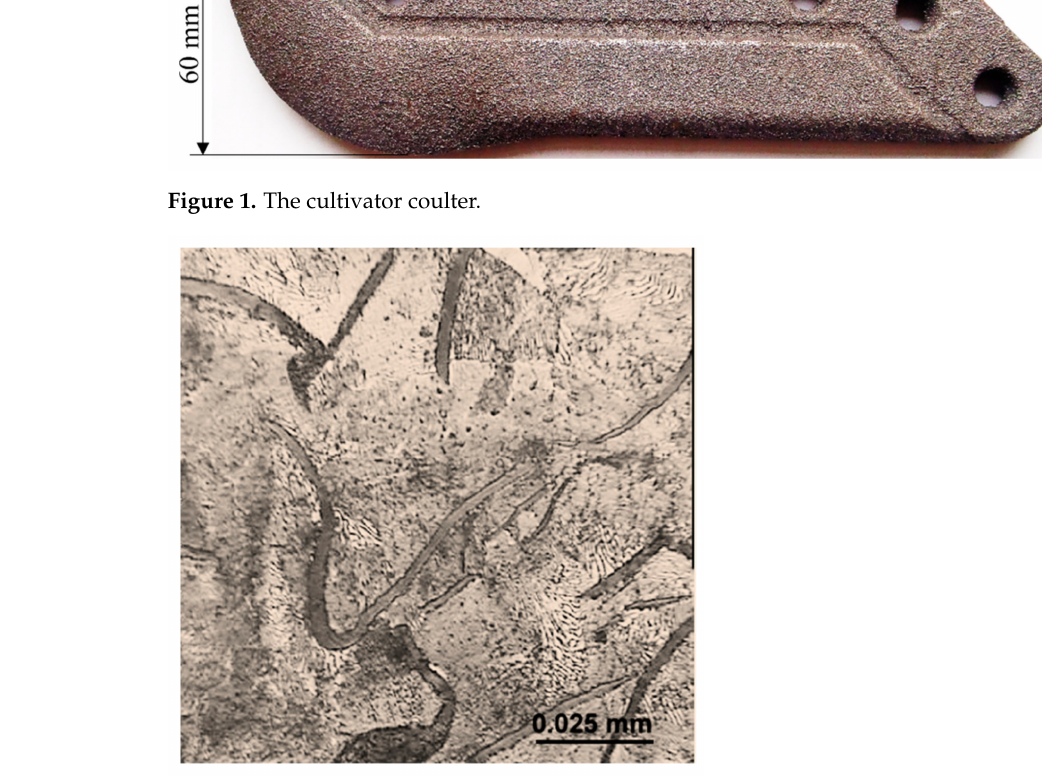
Figure 2. A microstructure in the core of the cultivator coulter.